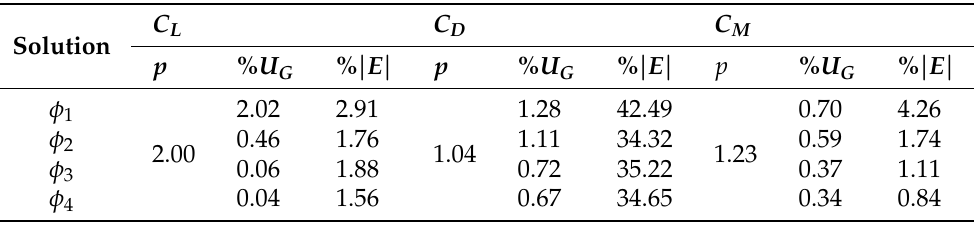
= 2,3,4,5, α = 15.2 ◦ ) with varying chord- N c R G i 0